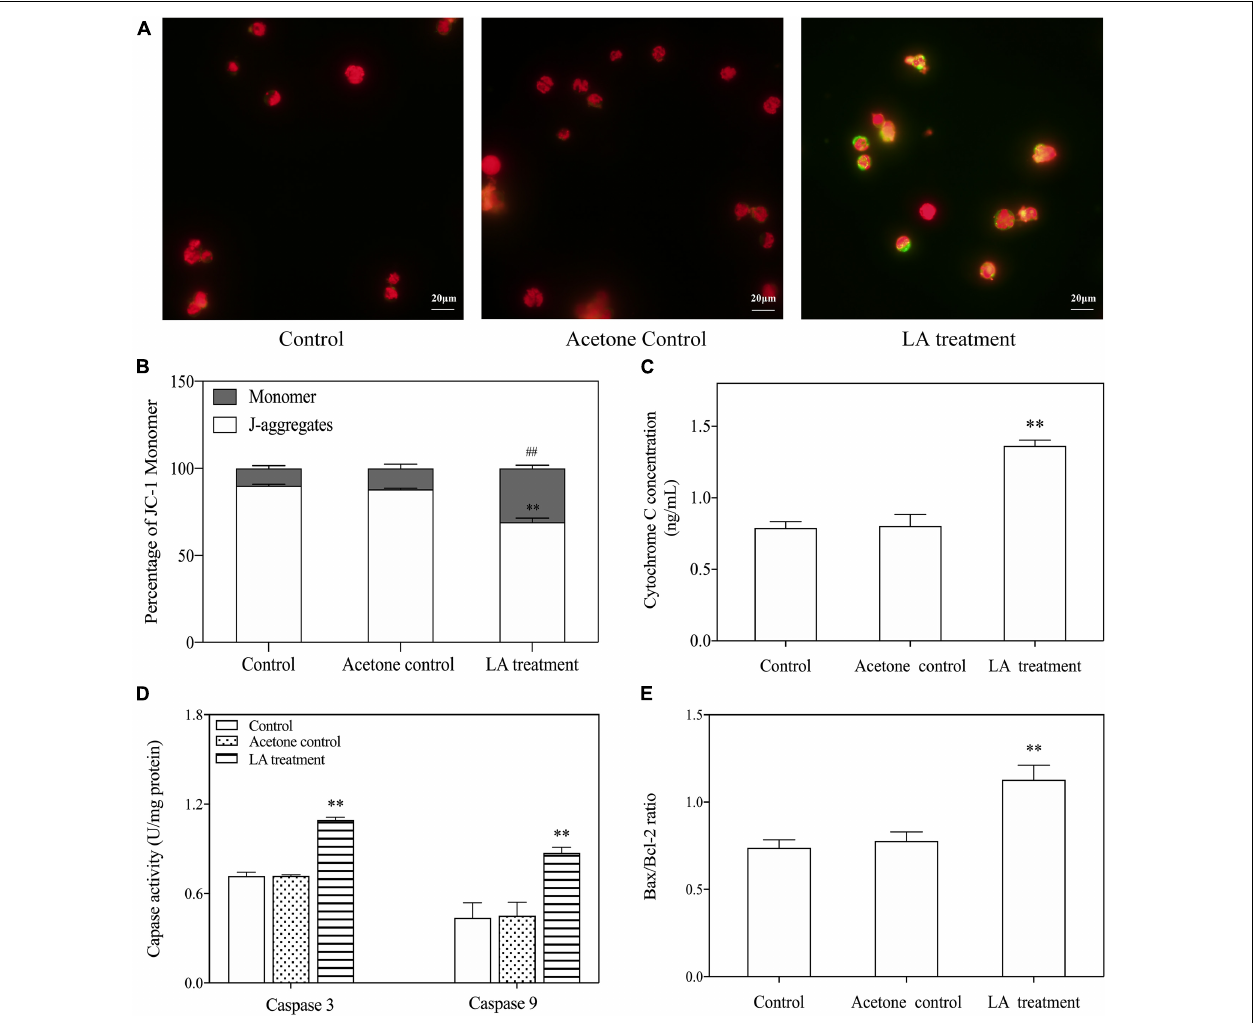
FIGURE 6 | Key components of LA-induced H. akashiwo cell apoptosis through the mitochondria-dependent pathway. (A) Fluorescence changes in stained cells by a fluorescence microscope. Red and green fluorescence indicates the normal and abnormal state of cell membrane potential, respectively. (B) Percentages of JC-1 monomers and J-aggregates. (C) Changes in the cytochrome c levels. (D) Changes in the Bax to Bcl-2 ratios. (E) Changes in the caspase-9 and caspase-3 activities. The data are presented as the mean ± SD ( n = 3). ∗∗ and ## indicate p < 0 . 01 relative to the acetone